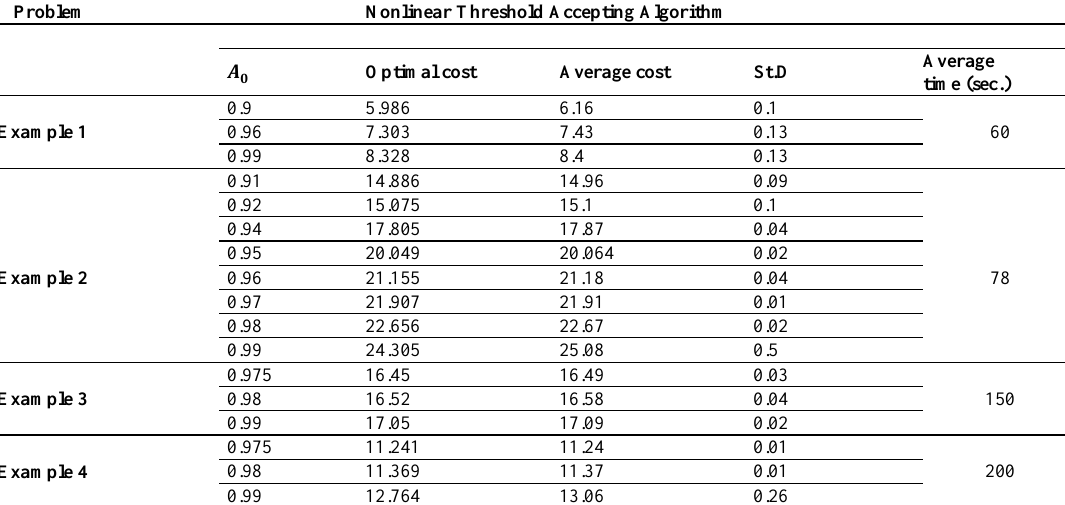
Table 1. Solutions found by NLTA (10